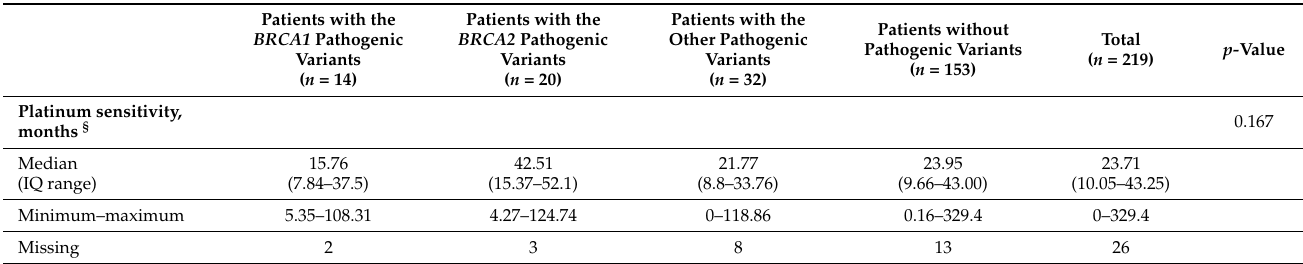
Table 3. Platinum sensitivity and mutational